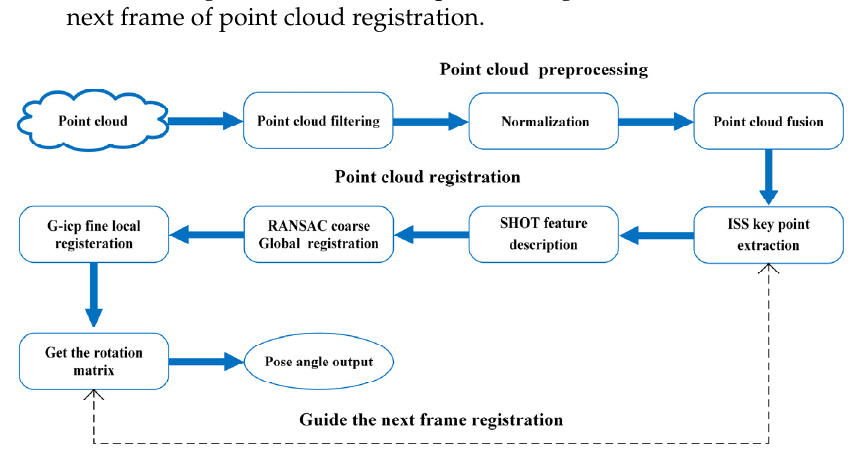
Figure 1. Overview of the proposed large ‐ scale aircraft pose estimation system.